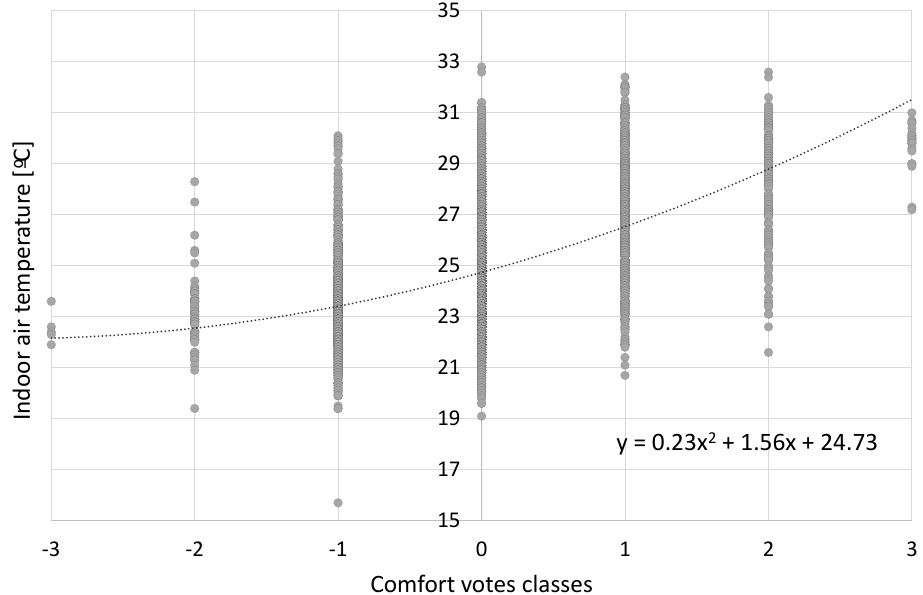
Figure 6. Indoor air temperature and thermal comfort votes scatter plot.